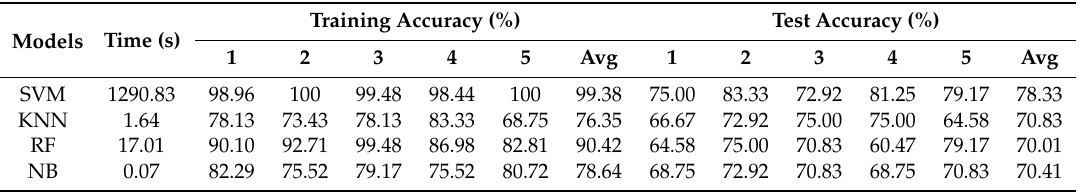
Table 1. The results of the support vector machine (SVM), K-nearest neighbor (KNN), random forest (RF) and naïve Bayes (NB) models on the thermal dataset, with 5 times 5-fold cross validation. Models Time (s)